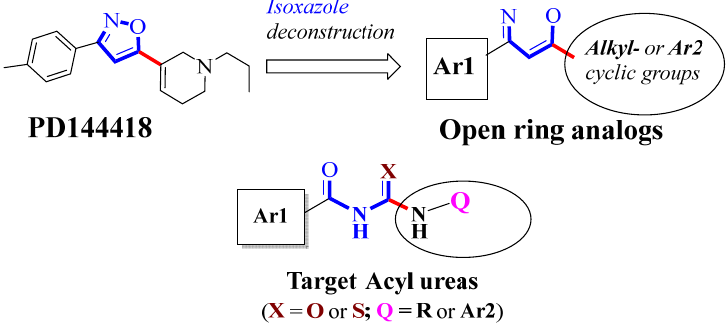
Figure 1. Acyl urea scaffold with alkyl ( R ), aromatic/heteroaromatic features ( Ar1 and Ar2 ). Online Molinspiration [13] and Osiris property explorer [14] were used to calcu ‐ late/predict drug ‐ like molecular properties for the target compounds. These studies in ‐ volved retrieving the σ 1R crystal structure (5HK1) with embedded ligand (PD144418), preparation (e.g., H 2 O and ligand removal), and docking the target molecules via the PyRx and AutoDock Vina suite [15,16]. All sixteen compounds comparably docked to the 5HK1 ligand binding site, suggesting that acyl ureas could also bind to σ 1R. Amino acid (AA) interactions in the receptor binding site were also revealed. Synthetically, a variety of ap ‐ proaches for obtaining acyl ureas were reviewed [17–29] and the most feasible conditions were attempted with limited success—our goal was to obtain our compounds using the shortest and most cost ‐ effective approach. In our hands, even the reported convenient Stokes’ method [23] which required obtaining the same key N ‐ (phenoxycabonyl)ben ‐ zamide intermediate from diphenyl carbonate, proved futile. Instead, 1 H NMR analysis of reaction mixtures revealed phenol, methyl benzoate, and remaining starting materials. We therefore slightly modified Stokes’ conditions [23] by preparing the N ‐ (phe ‐ noxycabonyl)benzamide intermediate from phenol and benzoyl isocynate. Coupling the intermediate with amines or amides or thioamides via simple nucleophilic displacement